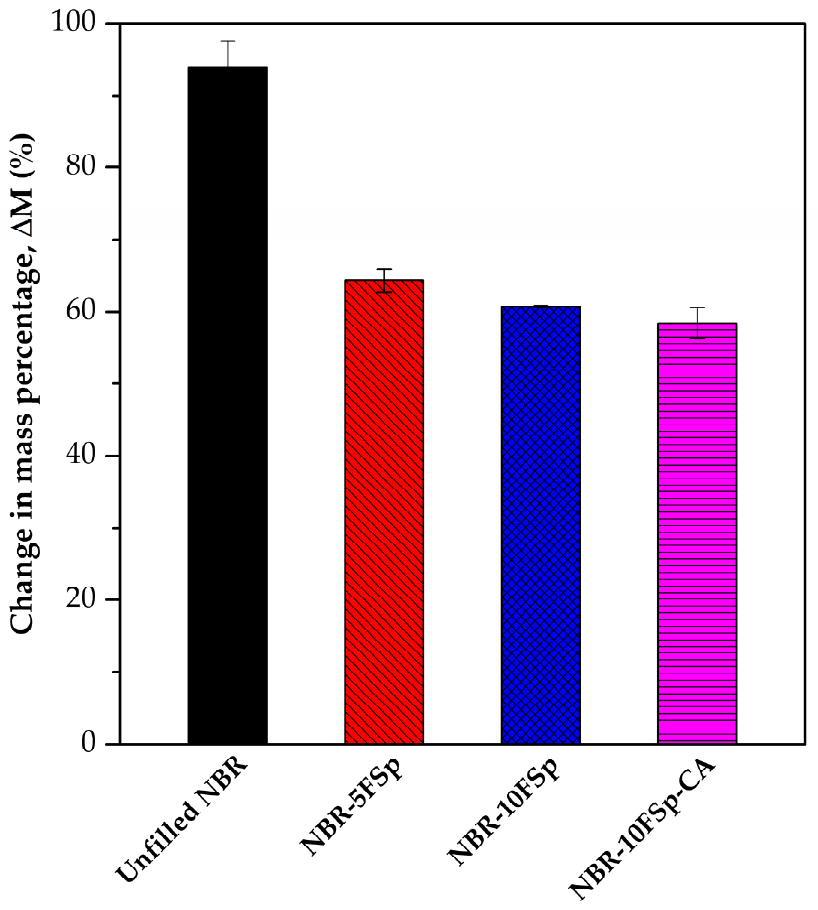
Figure 9. Oil resistance of NBR/FSp and NBR/FSp/CA composites.